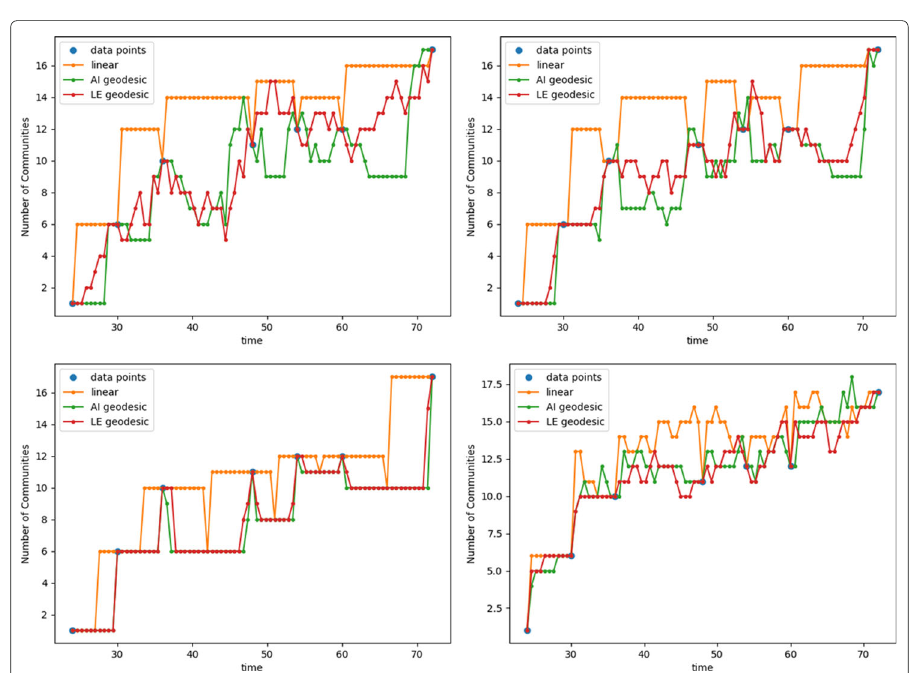
Fig. 9 Number of communities with ≥ 5 members in interpolated proteomics network. The changes in the number of communities with at least five members were perhaps most regular when no threshold was applied ( bottomright ). Applying thresholds of 0.02 ( topleft ), 0.1 ( topright ), and 0.5 ( bottomleft ) produced greater differences between the linear and geodesic